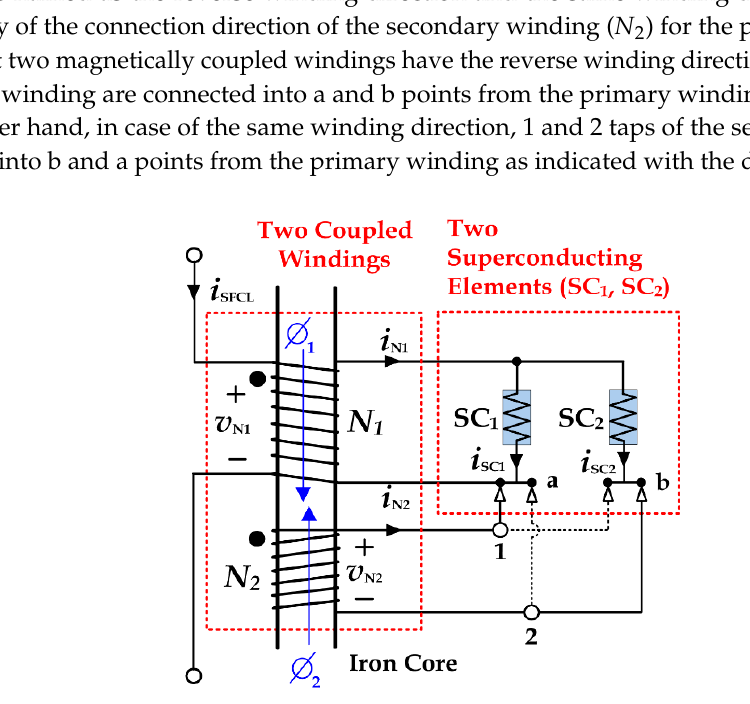
Figure 1. Schematic configuration of the SFCL using two magnetically coupled windings.